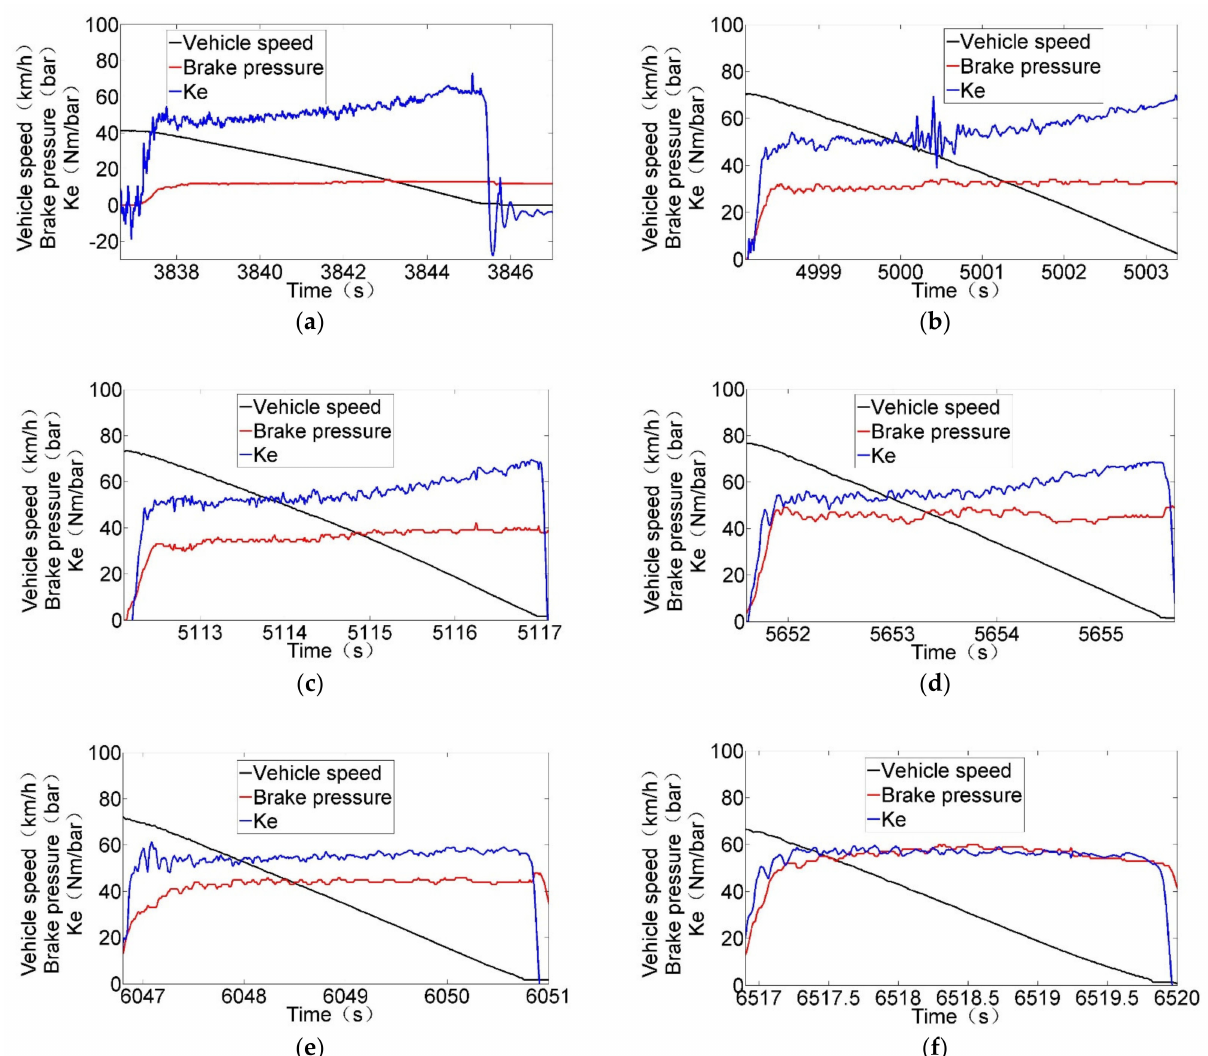
Figure 9. Evolution of K e under different initial temperatures of the brake discs: ( a – f ) represent different initial disc temperatures of test groups 1–6, shown in Table 2,